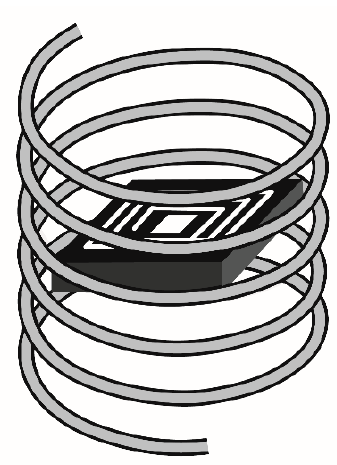
Figure 4. Schematic of the RFID used in the second experiment embedded in a spiral antenna.